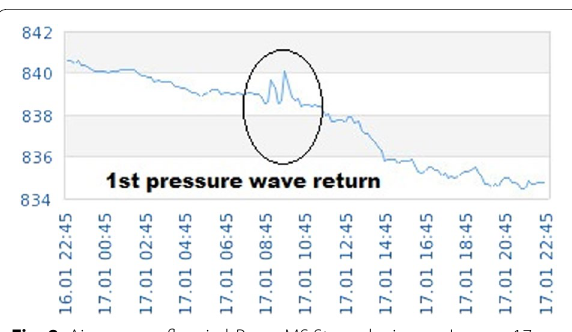
Fig. 8 Air pressure flow in hPa on MS Stara planina on January 17, 2022 (x-label denotes date and time: 16.01. 22:45 (January 16 at 22:45 CET); time is given in CET (UTC +